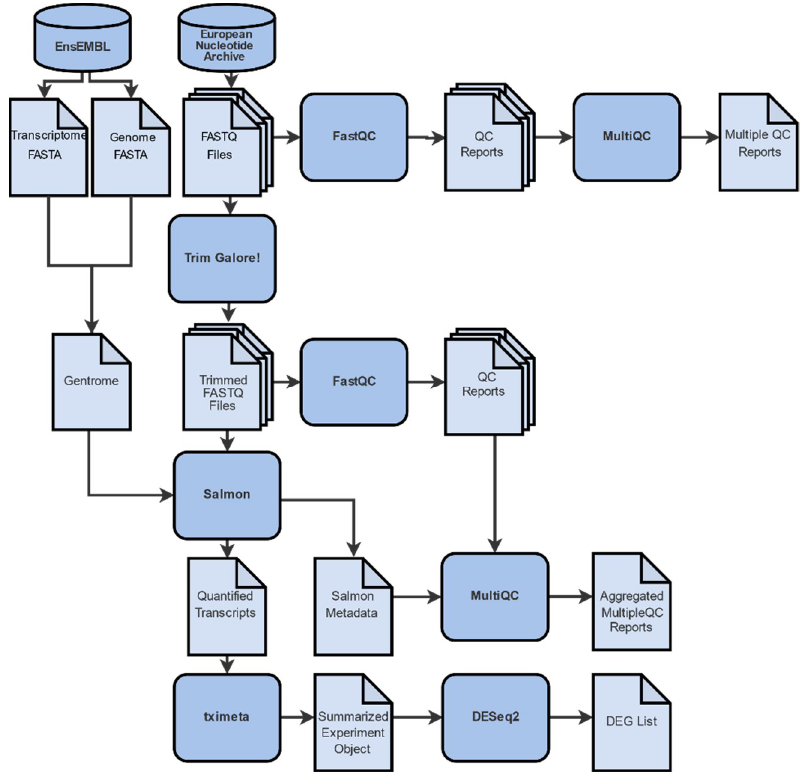
Figure 3. Differential gene expression analysis workflow is comprised of 4 distinct steps: A) Data collection from the online repositories ENA and EnsEMBL. B) Quality control and trimming. A conventional analysis pipeline of RNA-Seq data starts with the pre-processing of the raw reads with FastQC, MultiQC, and Trim Galore! C) Gene abundance quantification with Salmon and tximeta by mapping of the reads to a reference genome and/or transcriptome. D) Differential gene expression analysis with DESeq2, where gene expression levels of all mapped transcripts are quantified and normalized in order to define differentially expressed genes.